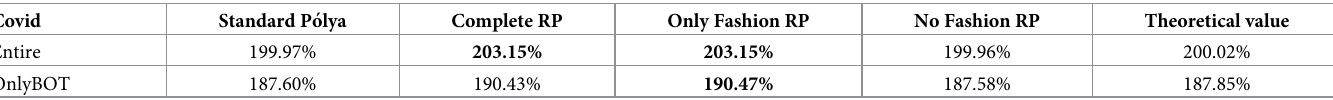
Table 6. “Covid” sample ( T = 0.35, D = 3 0 , S = 1000 slots of equal size): Comparison of the different considered models in terms of (6).